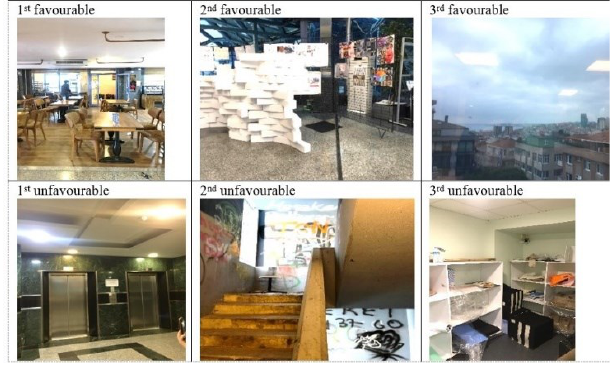
Table 3. Example photos were taken by students from vertical campus using the PPM